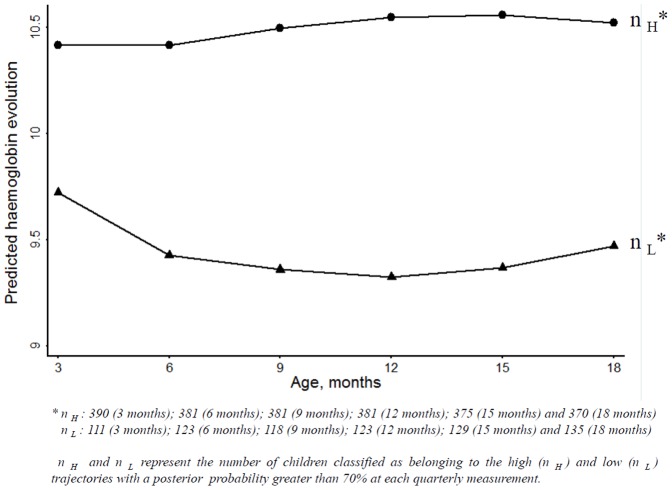
Trajectories for haemoglobin (3 to 18 months of age).